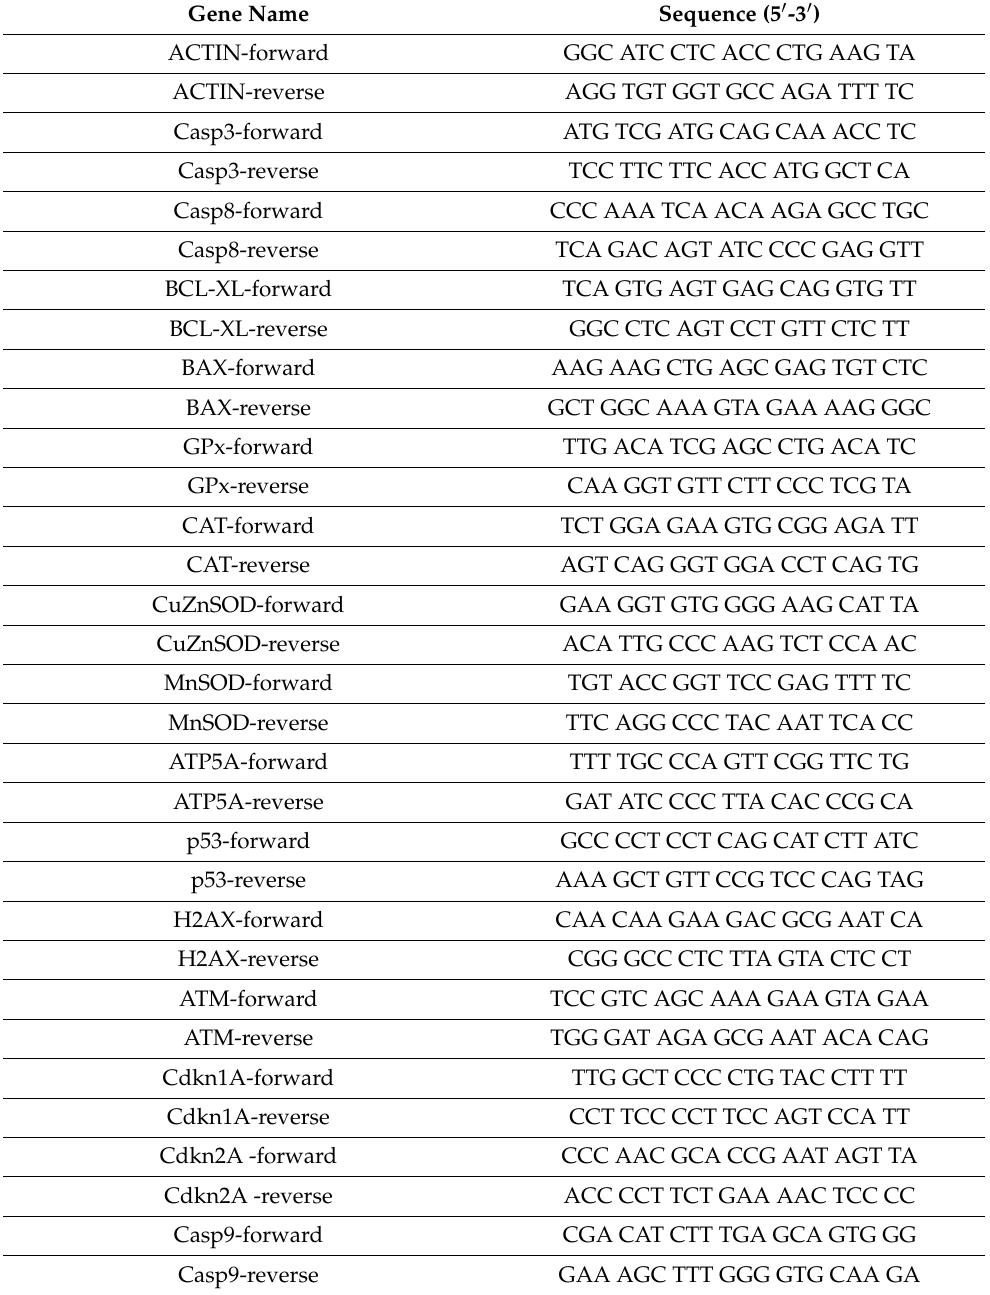
Table 1. List of primers used in this